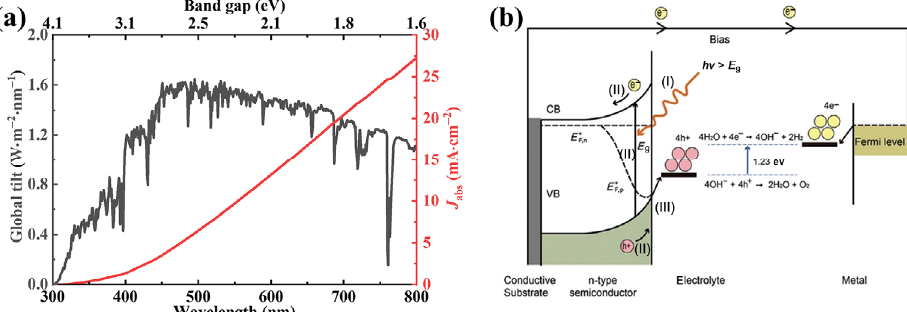
Figure 2 (a) Relationship between the solar spectrum and E g and the STH efficiency of semiconductors. (b) Main reaction processes of photogenerated carriers in PEC water-splitting devices (reproduced with permission from Ref. [32], © The Royal Society of Chemistry 2017): (I) light absorption process, (II) bulk phase separation process, and (III) surface catalytic process of photogenerated